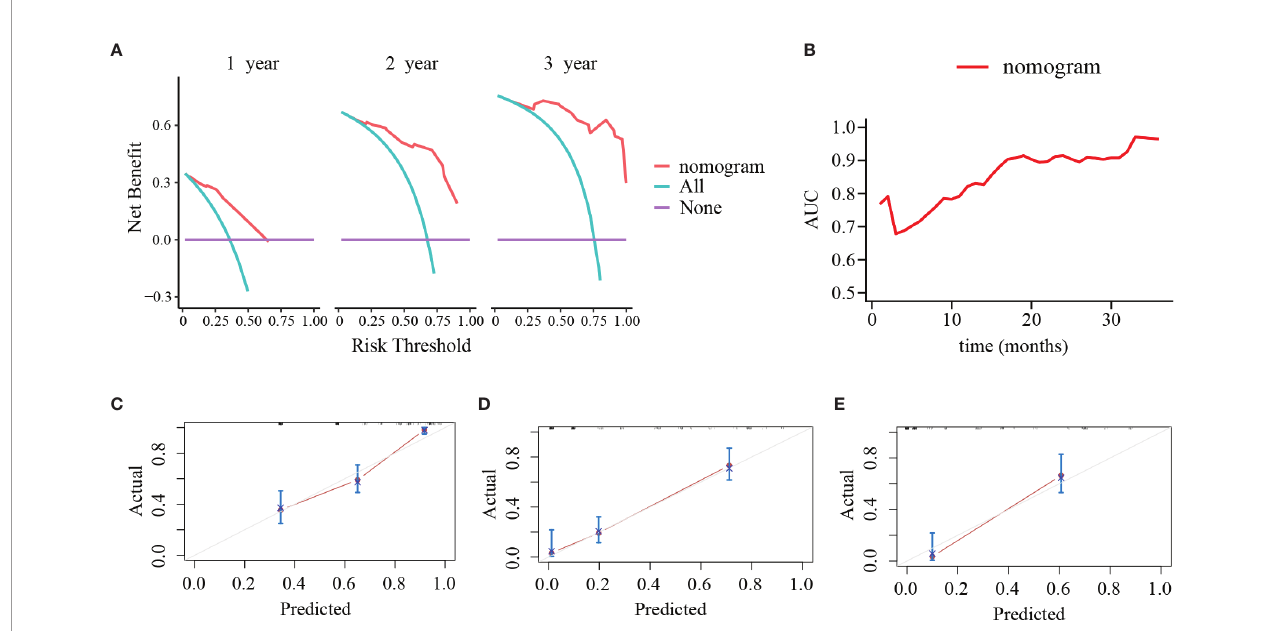
FIGURE 6 | Decision curve analyses (DCA), time-dependent receiver operating characteristic (ROC) curve and calibration curves of the nomogram. (A) DCA of the nomogram at 1, 2, and 3 years after surgery. The y-axis represents the net bene fi t and the x-axis represents the corresponding risk threshold. The blue line represents that all patients die during the follow-up. The purple line represents that no patients die during the follow-up. The red line represents the net bene fi ts of nomogram at different risk threshold. (B) The predictive value of the nomogram at different points of follow-up after surgery. (C – E) The calibration curves of the nomogram to predict (C) 1-year, (D) 2-year, and (E) 3-year survival rates. The y-axis represents actual survival and the x-axis represents the predicted survival probability based on nomogram. The gray oblique line represents the ideal prediction and the red line represents the performance of the nomogram. Close fi t to the grey oblique line indicates the consistency between the predicted and observed survival